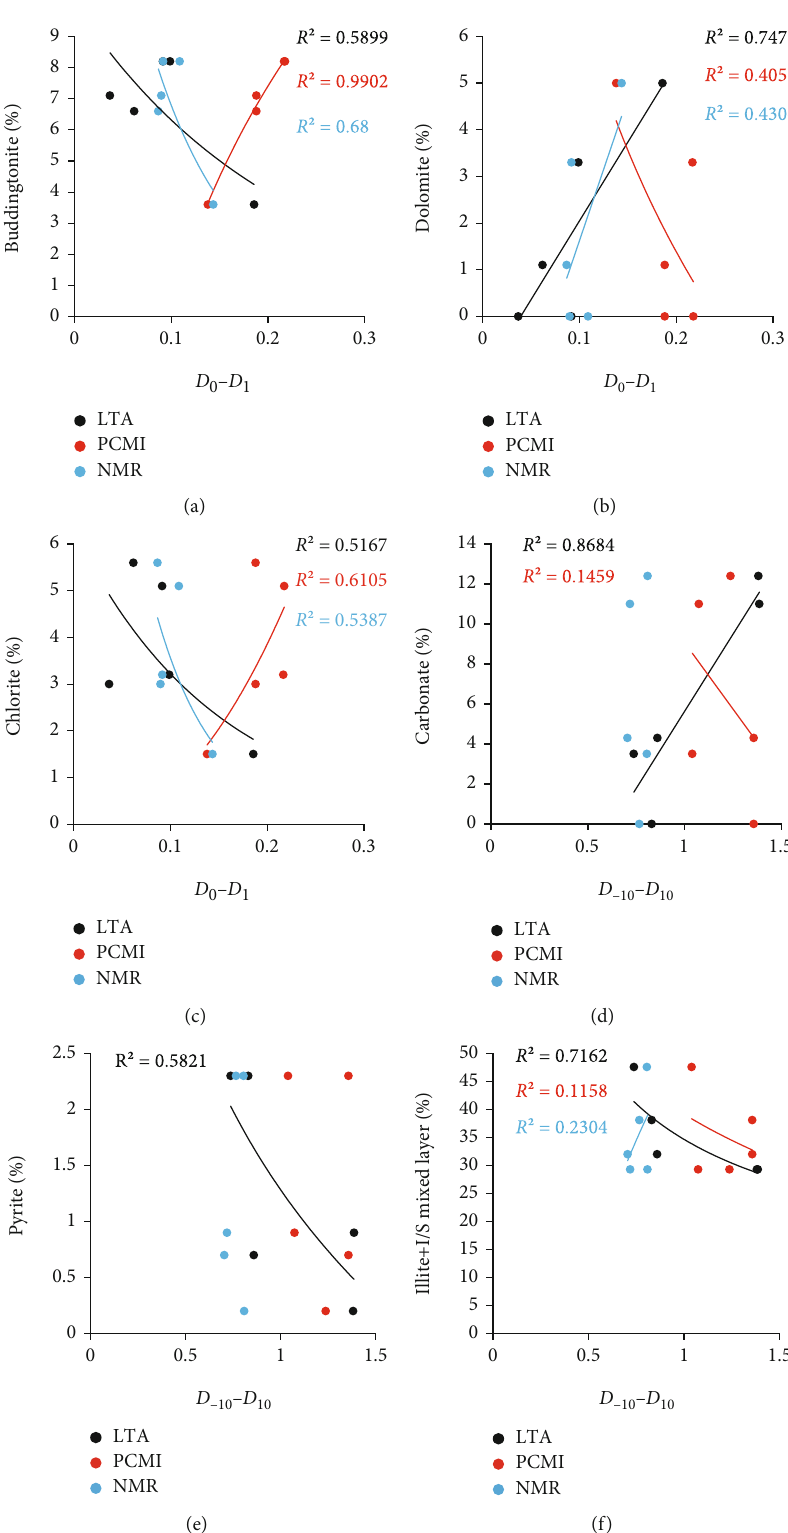
- D vs. (a) buddingtonite; (b) carbonate; (c) clay (chlorite in this case), 0 1